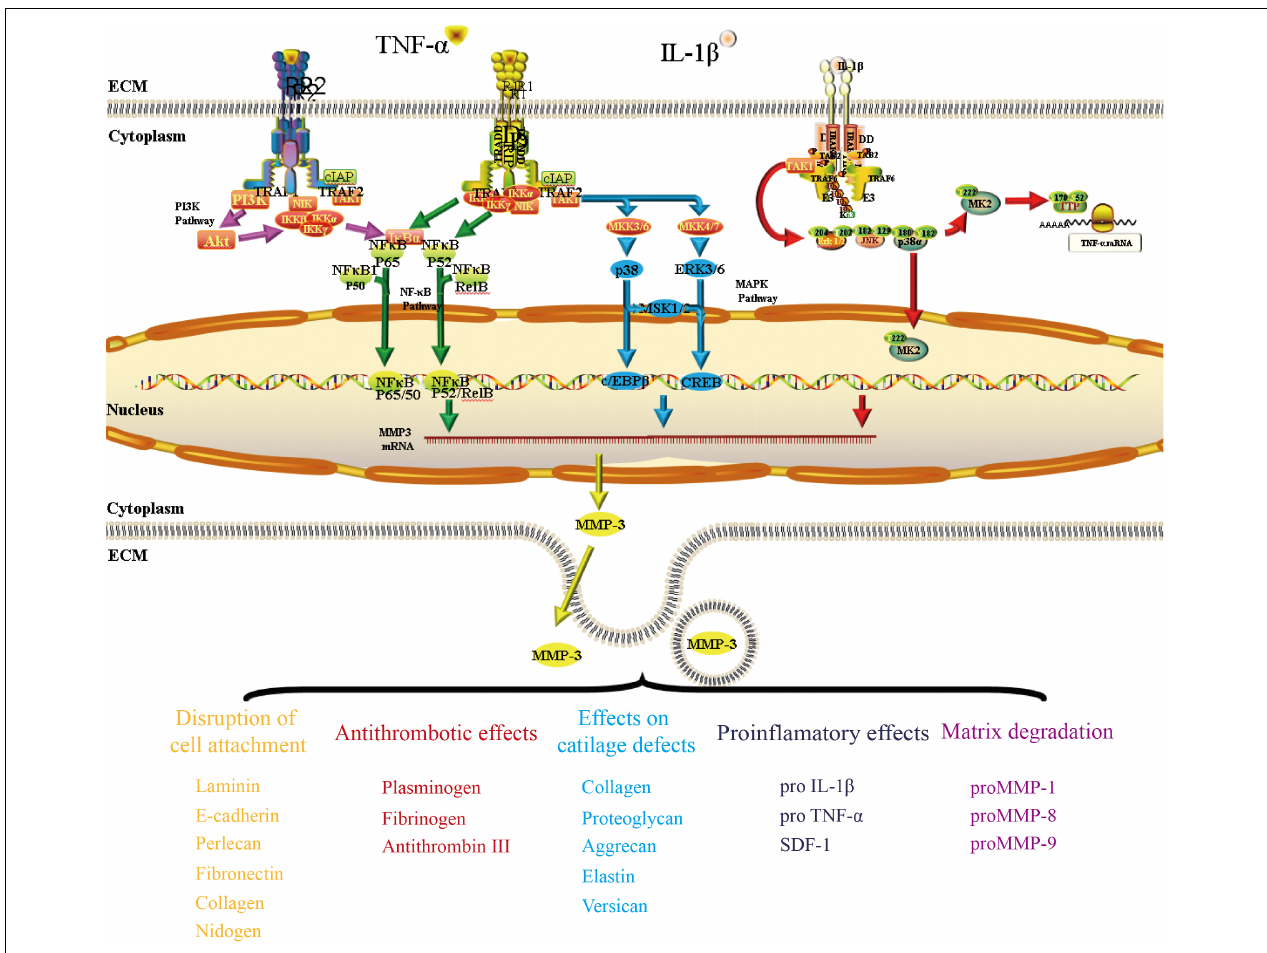
FIGURE 3 | The mechanism by which TNF- α and IL-1 β regulate MMP-3 expression in OA. This figure presented three pathways (NF- κ b pathway, MAPK pathway, and PI3K/Akt pathway) that have been mentioned a lot when discussing the regulation of MMP-3 expression. TNF- α can bind to its traditional receptor TNFRI or non-classic receptor TNFRII and pass the signal through both NF- κ b pathway. The transcriptional factor NF- κ b could bind to the promoter of MMP3 gene and regulate MMP-3 expression. The binding of TNF- α and its receptors could also activate the TAK1 and then pass the signal through MAPK pathway. IL-1 β could bind to its receptor and regulate MMP-3 expression through PI3K/Akt